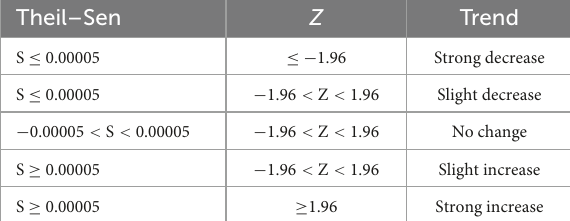
TABLE 1 The table of trend change